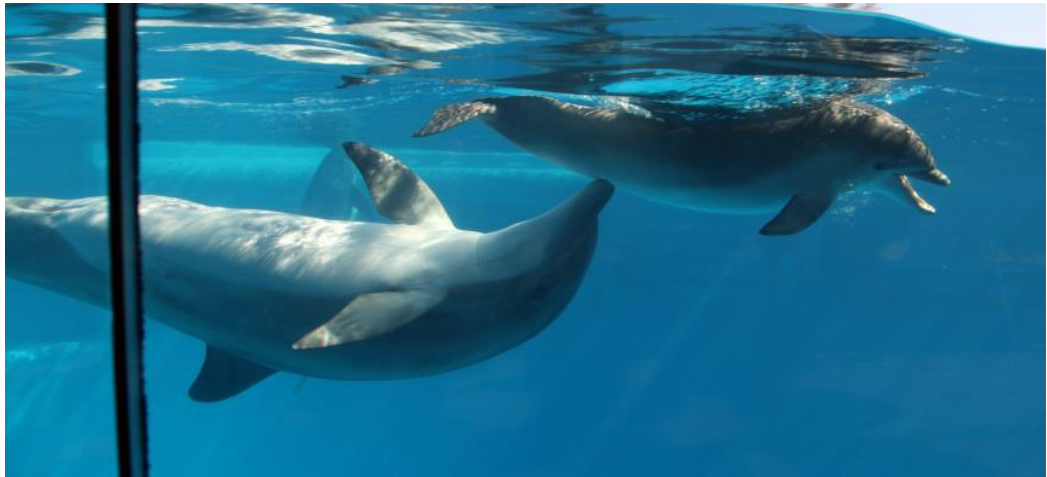
Figure 10 . A dolphin mother gooses her 3 month old female